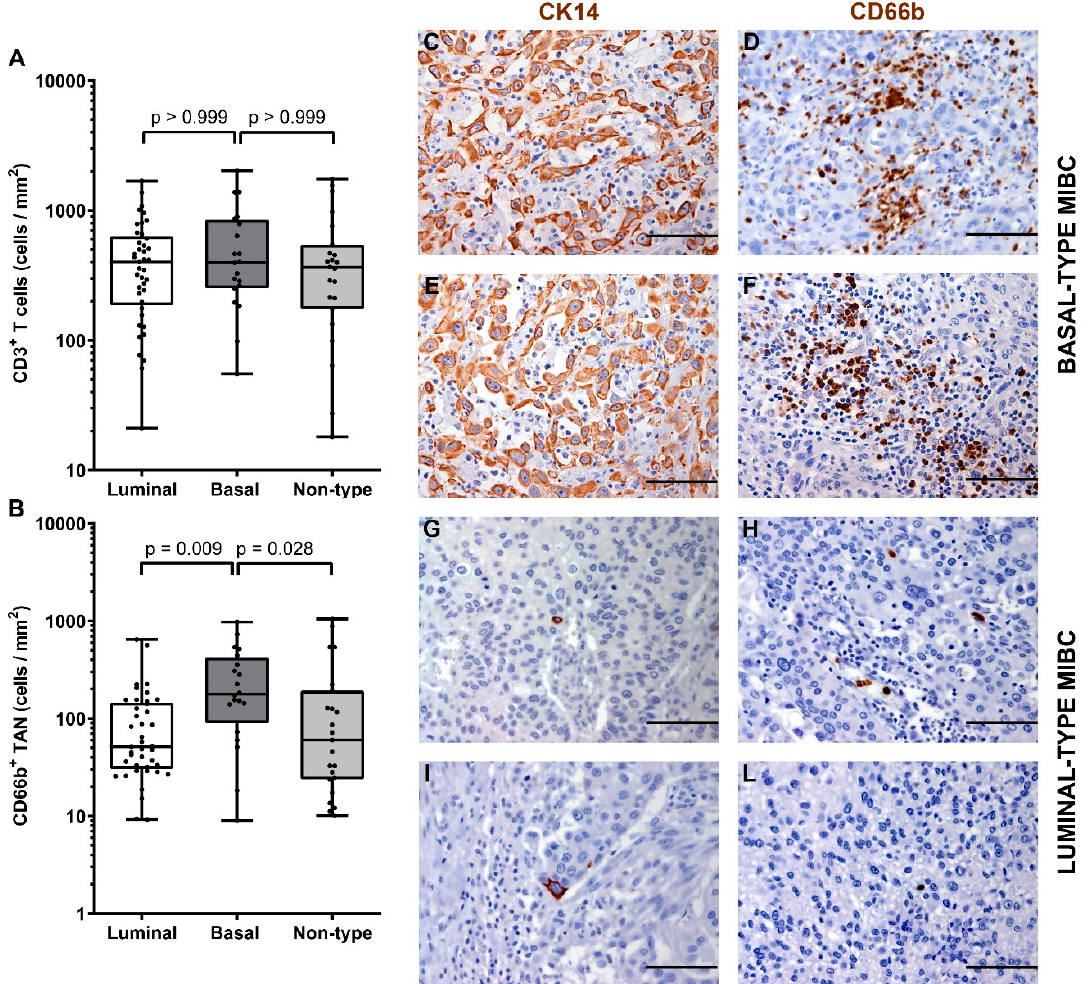
Figure 5. Density of CD66b + TAN and CD3 + T cells in basal and luminal MIBC. Dot plots indicating the density of CD3 + T cells ( A ) and CD66b + TAN ( B ) in the MIBC cohort subdivided by molecular subtypes. Sections from two basal-type MIBC cases (case 70 and 49, in C – F ) and two luminal-type MIBC cases (case 25 and 34, in G – L ) are stained as labeled and counterstained with hematoxylin; magnification 200 × (scale bar 100 micron). p values were estimated by Kruskal-Wallis test and adjusted for multiple pairwise comparisons.